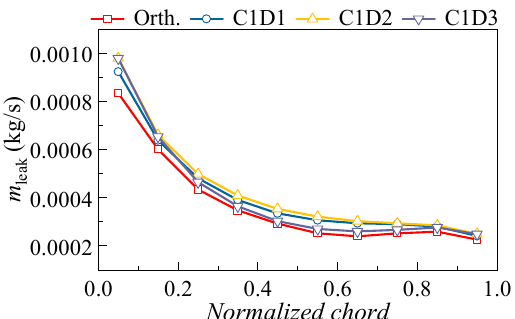
Figure 22. Radial distribution of aerodynamic performances for the cases with different dihedral angles. ( a ) φ = 0.52; ( b ) φ = 0.46.